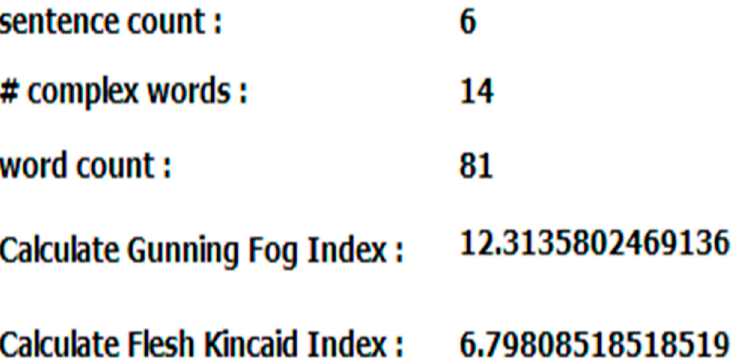
Figure 6. System calculations section view.